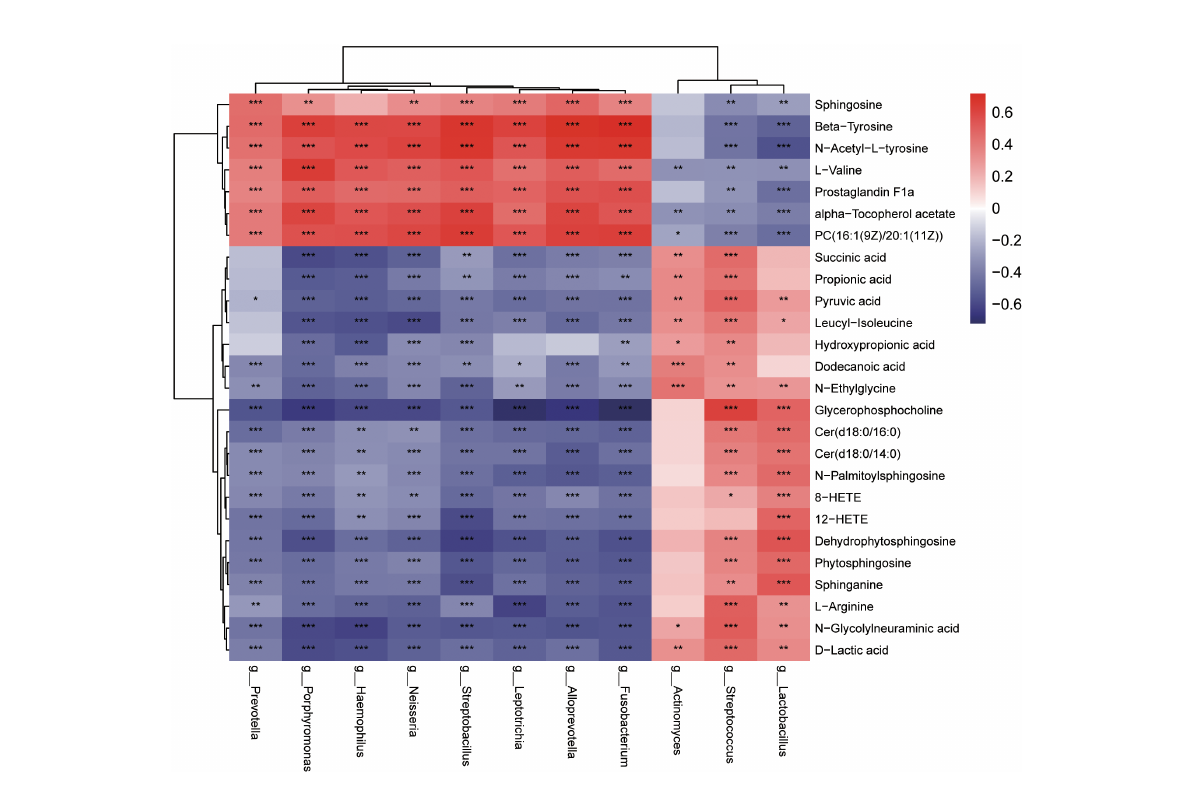
FIGURE 8 Heatmaps indicate the Spearman rank-correlation coef fi cients for the relative abundance of differential oropharyngeal microbiota at the genus level and differential metabolites in children with IAV pneumonia and healthy controls. Positive correlation is depicted using red, whereas negative correlation is depicted using blue. * p < 0.05; ** p < 0.01; *** p < 0.001; IAV, in fl uenza A